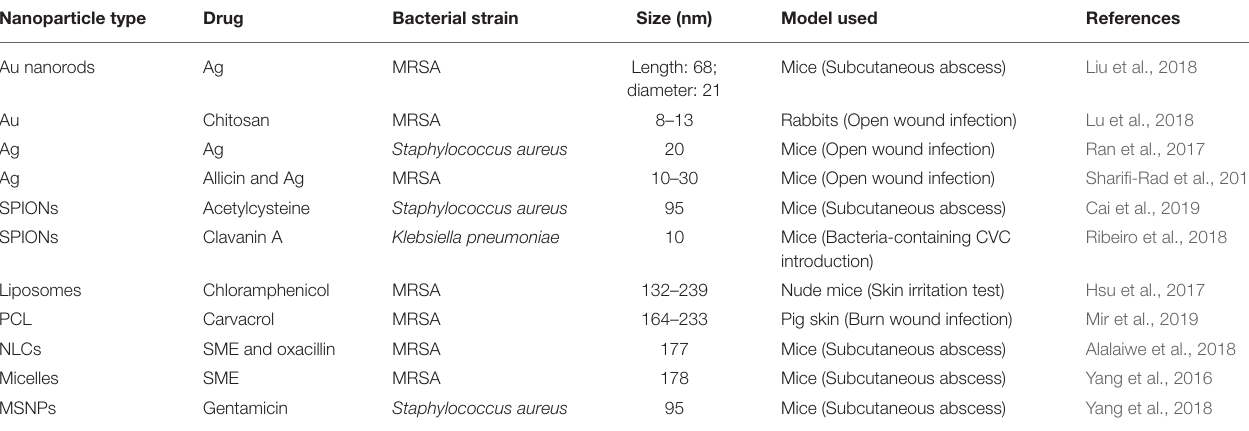
TABLE 1 | Summary of nanoparticle-based approaches for skin and subcutaneous bacterial infections tested in animal studies. Nanoparticle